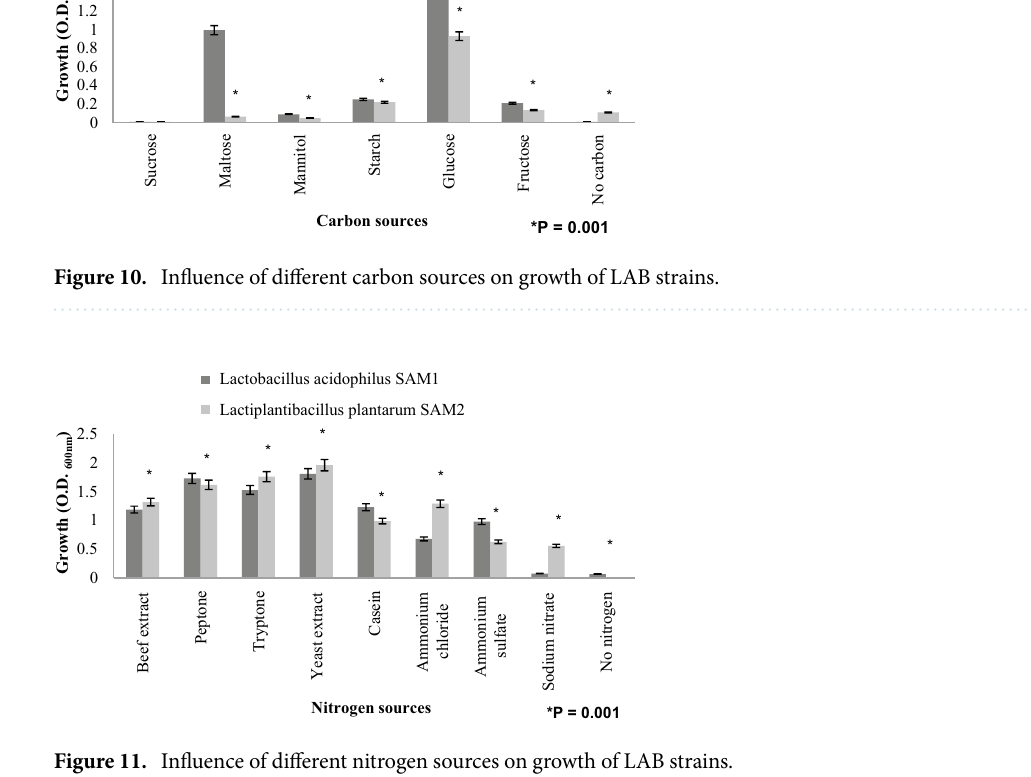
Figure 11. Influence of different nitrogen sources on growth of LAB